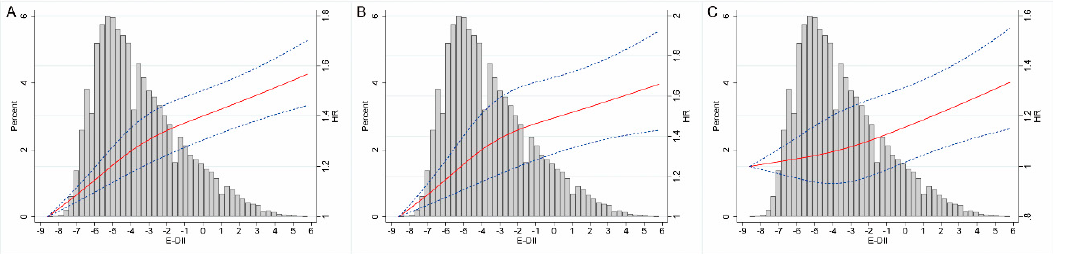
Figure 1. Dose—response analyses for the association between all—cause ( A ), CVD ( B ), or cancer mortality ( C ) and E—DII were performed using a restricted cubic spline model with 3 knots at the 10th, 50th, and 90th percentiles. Red solid lines represent point estimates, and blue dashed lines represent 95% CIs. The histograms show the percentage of participants (left y-axis) belonging to each level of E—DII. CVD—cardiovascular disease; E—DII—Energy—adjusted Dietary Inflammatory Index; CI—confidence interval.